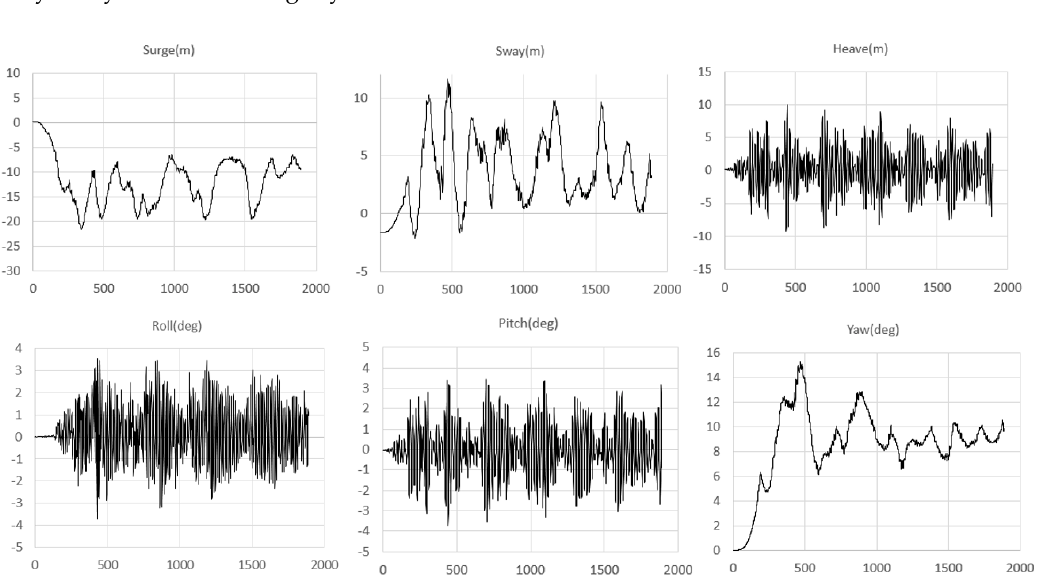
Figure 20. 6DOF Motions by Penalty Programming (Single-Alignment Thruster Configuration).